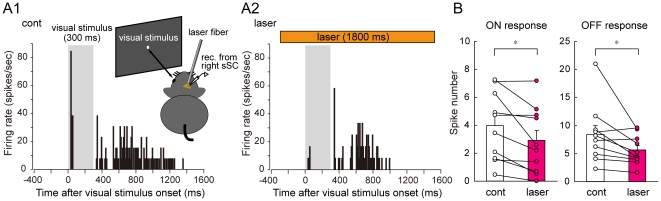
Laser illumination partially, but significantly blocked sSC-spiking activities induced by visual stimulation in vivo.
A, PSTHs showing spiking activity evoked in a cell by visual stimulation (300 ms duration) during control (cont; A1) and laser illumination onto the sSC surface before, during, and after the visual stimulation (from −300 to 1500 ms after the onset of visual stimulation) (laser; A2). Hatched areas represent the duration of visual stimuli. Inset: Schematic of experimental setup for extracellular recordings and laser illumination in vivo. B, Population data from 10 cells depicting the effects of laser illumination on both ON and OFF responses to visual stimuli. *P<0.05.